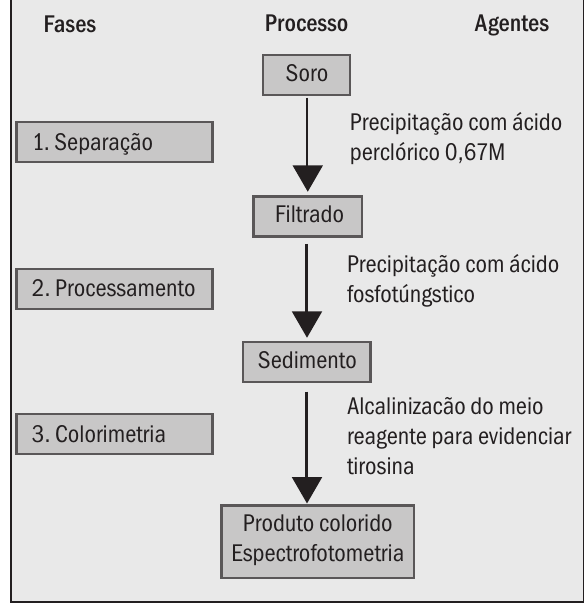
Figura 1 – Fases do procedimento analítico para quantificacão das mucoproteínas pelo método de Winzler (10,